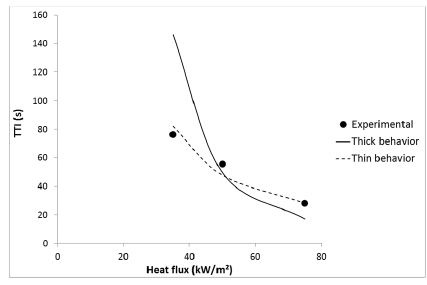
Figure 12. Experimental and predicted TTI versus heat flux for LDPE.